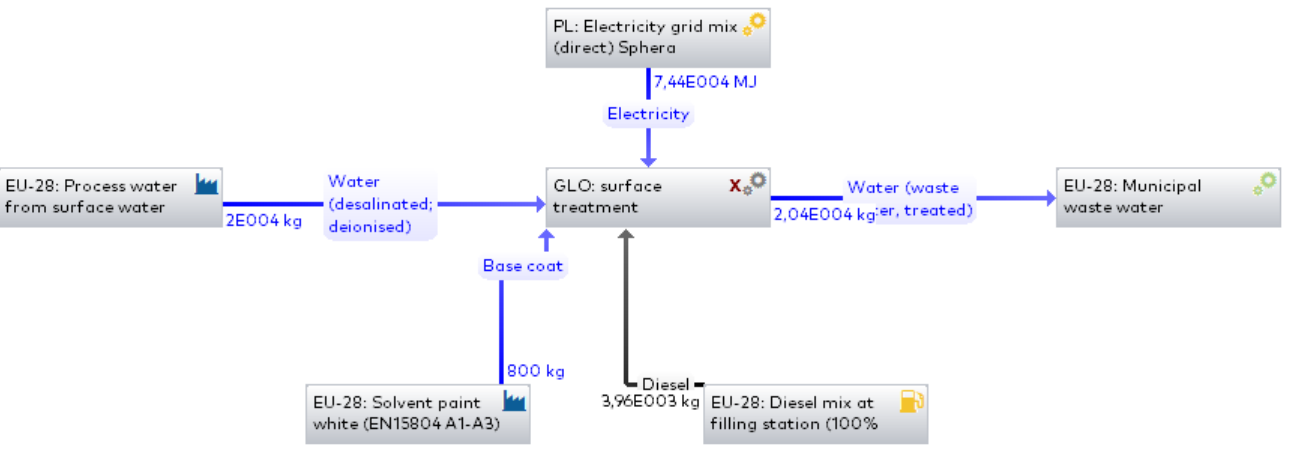
Figure 8. Refurbishment process of steel sections. Table 4. Material balance by scenarios.